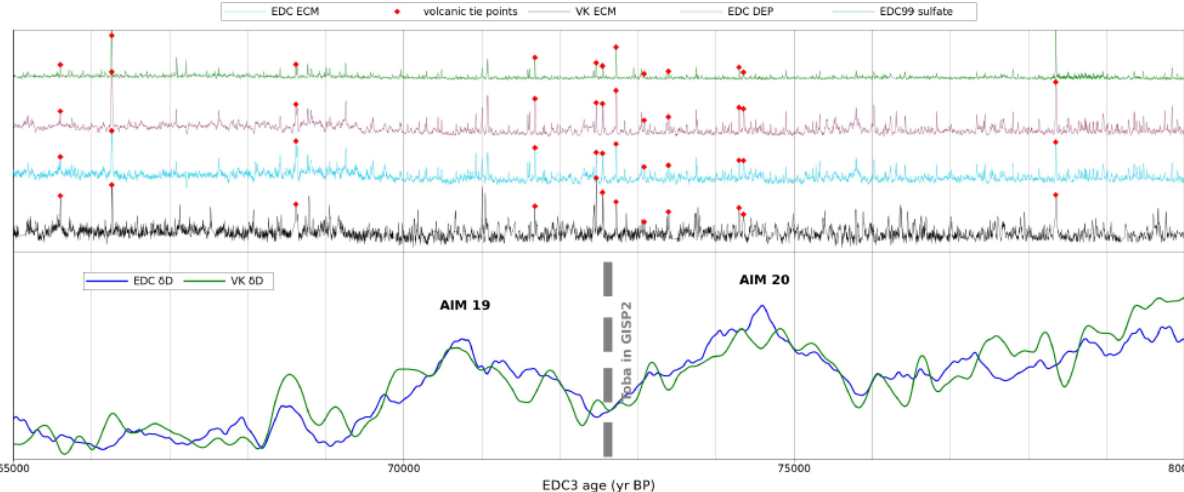
Fig. 9. Vostok – EDC synchronisation during the period 65–80kyrBP, centered on the likely age of the Toba eruptive event. All records have been placed on the EDC3 age scale. (Top) Black: ECM record from the VK-5G ice core. Blue: ECM record from the EDC96 and EDC99 ice cores. Purple: DEP record from the EDC99 ice core. Green: sulfate records from the EDC96 and EDC99 ice cores. Red diamonds: volcanic tie points. For simplicity, the y-axes are not plotted. (Bottom) Blue: Deuterium record from the EDC ice core. Green: Deuterium record from the Vostok ice core. For simplicity, the y-axes are not